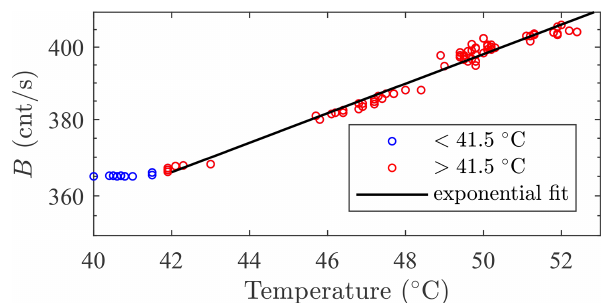
Figure 23. Variation in B due to dark-current increase with the in- strument enclosure temperature above the 41.5 ◦ C (1040nm chan- nel). These measurements were acquired with the SPST05/M703 instrument during the Halifax campaign. The stabilized dark cur- rent is 365cnts − 1